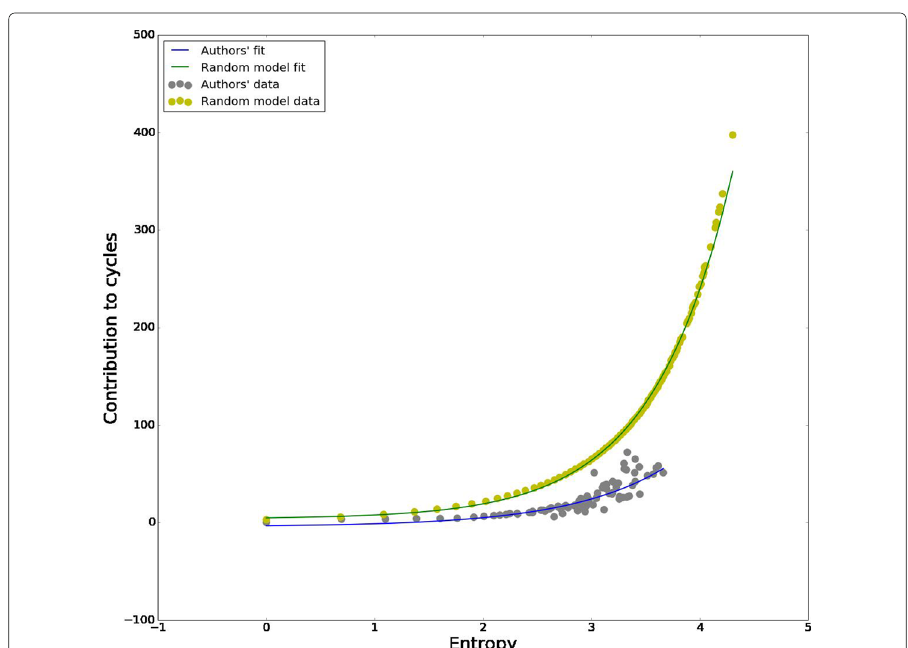
Fig. 15 Authors’ contribution to cycles versus null model. Here we compare the contribution to homological cycles as a function of authors’ entropy in our dataset with average contribution over the null model, the latter being always above the fit for authors’